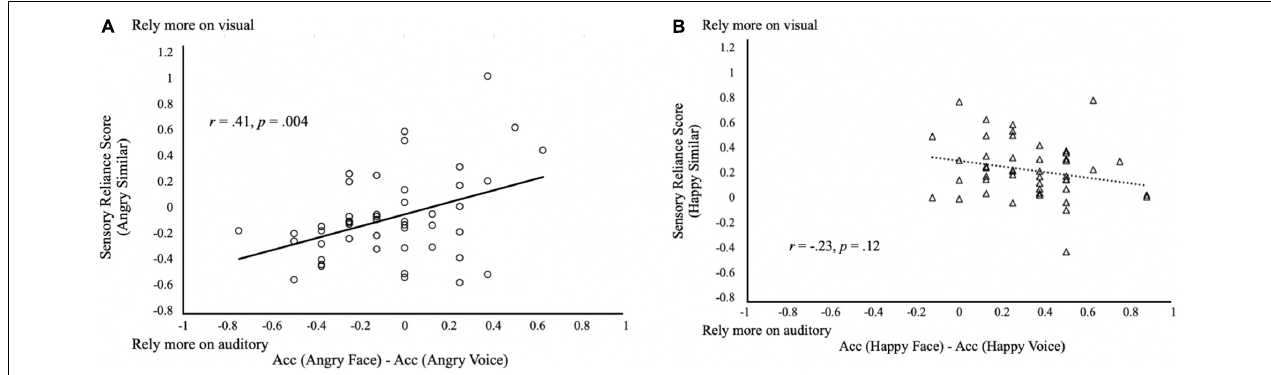
FIGURE 5 | Reliability-weighted multisensory integration model. Relationship between the difference in the audiovisual difference in emotion recognition accuracy and the sensory reliance scores in the Similar trials with (A) angry stimuli; and (B) happy stimuli. Positive values in sensory reliance score indicate a higher reliance on visual input, and negative values indicate a higher reliance on auditory input during multisensory emotion